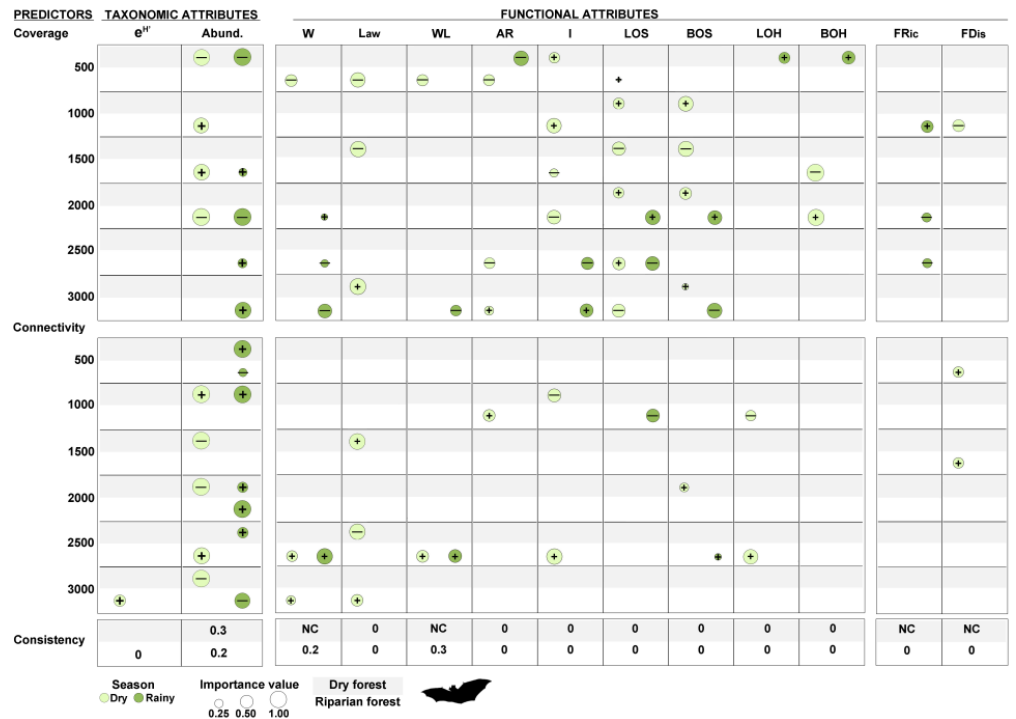
Figure 4. Landscape attributes associated with variations in bat taxonomic and functional diversity during the dry and the rainy season. Bubble size corresponds to the degree of importance (importance value) of each predictor and bubble color corresponds to the season. The direction of